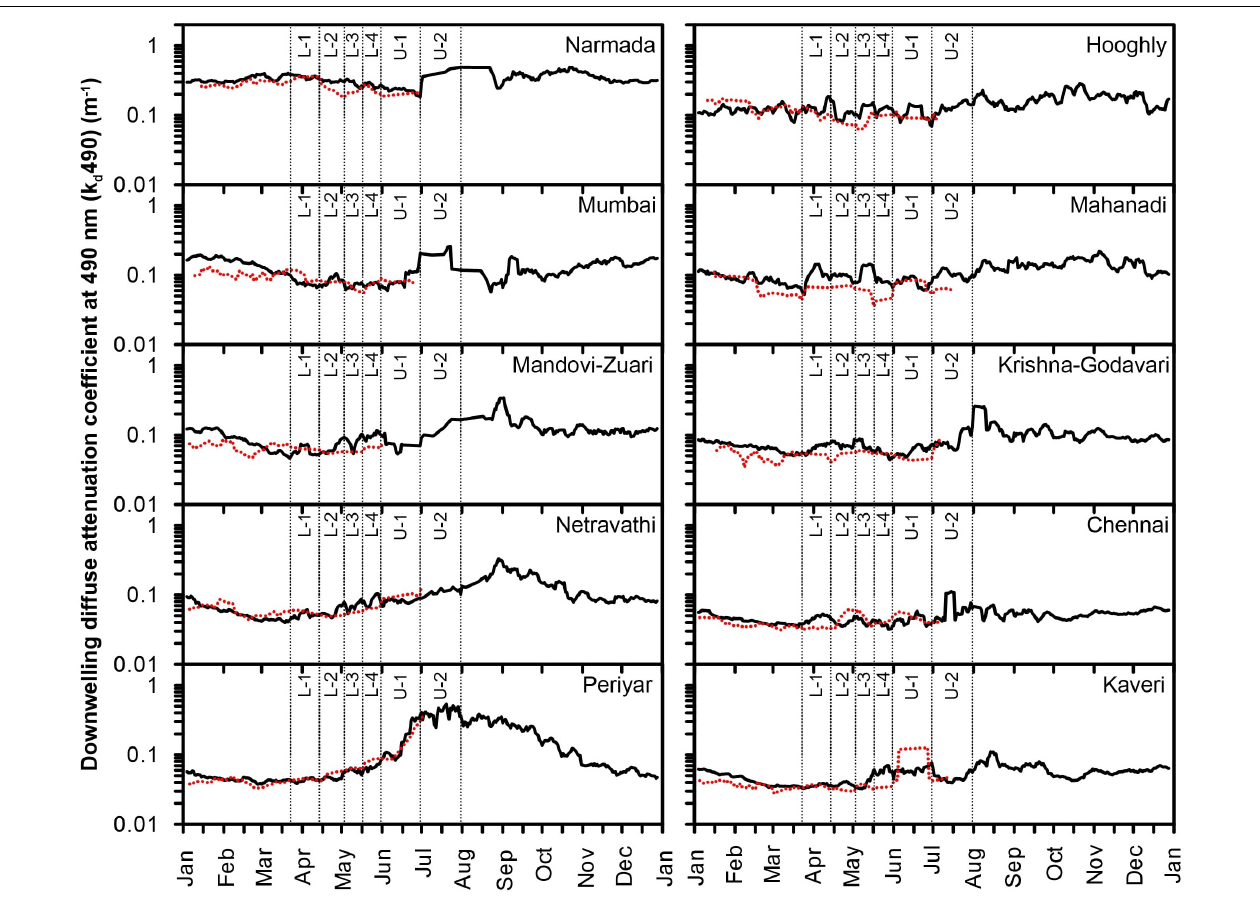
FIGURE 4 | Mean time-series variability in k d 490 climatology (solid black line) and for the year 2020 (dotted red line) off major Indian cities and river